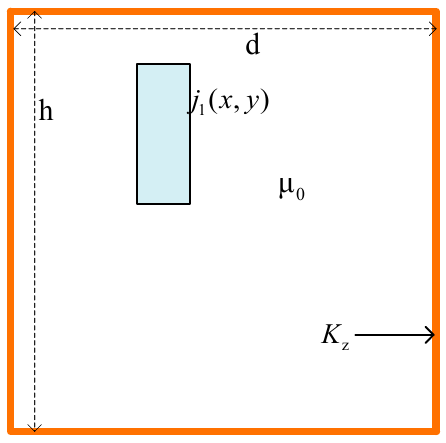
Figure 7. Additional surface current on the air boundaries.